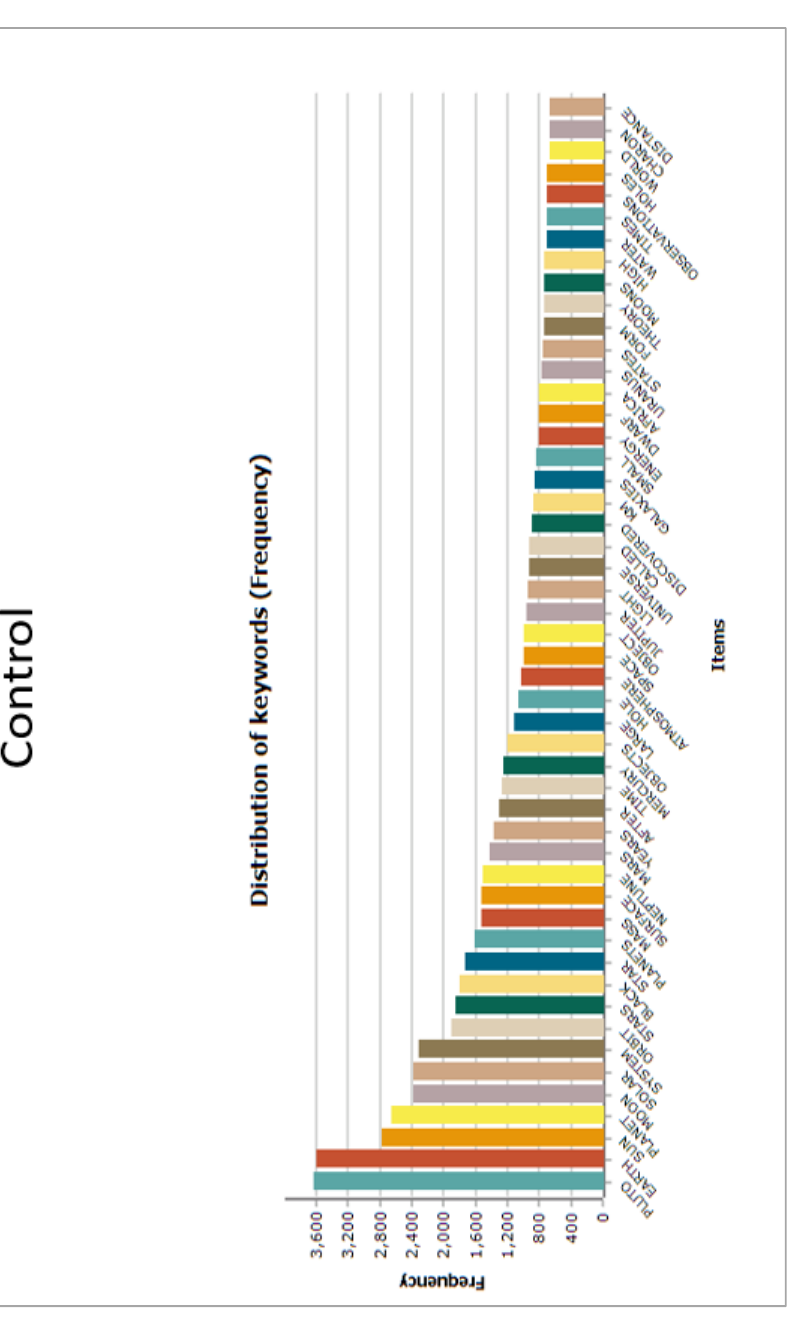
Fig. 6. Distribution of keywords for control